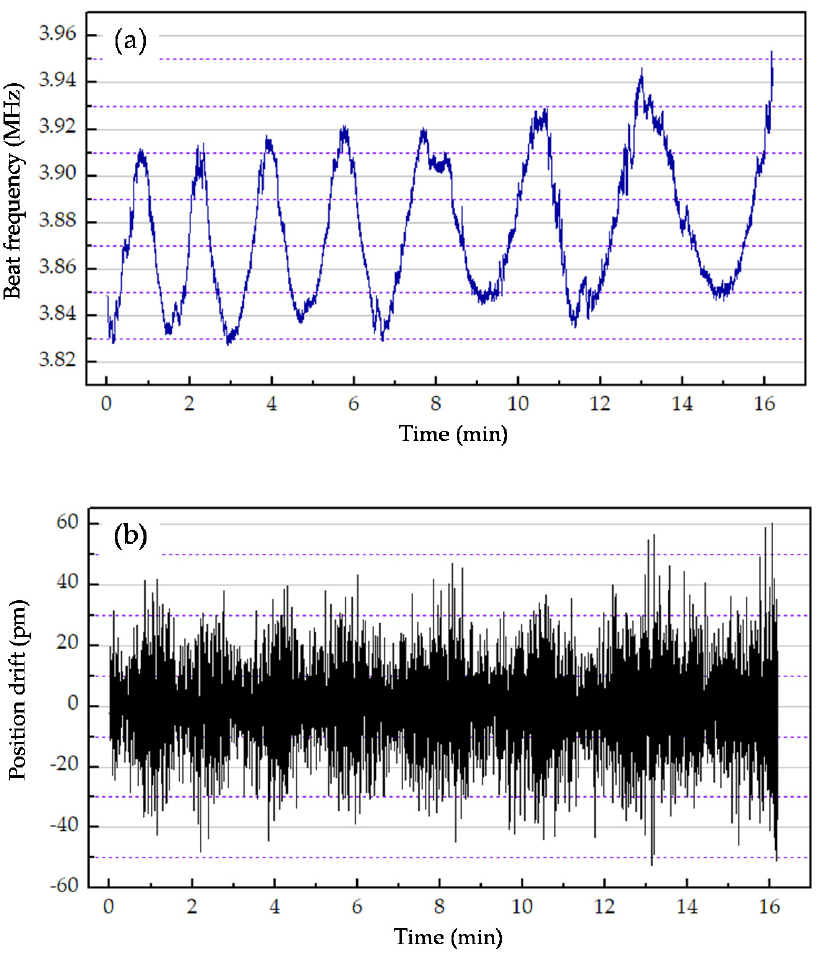
Figure 3. Scheme for the relationship between the beat frequency and the position drift: ( a ) beat frequency and ( b ) position drift.